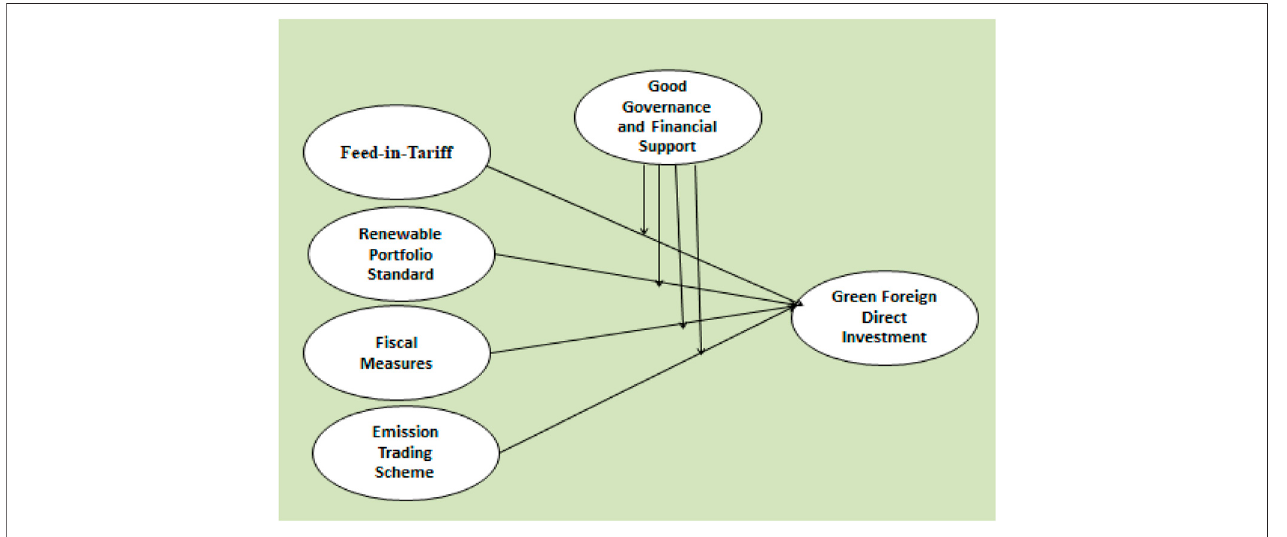
FIGURE 1 | Conceptual